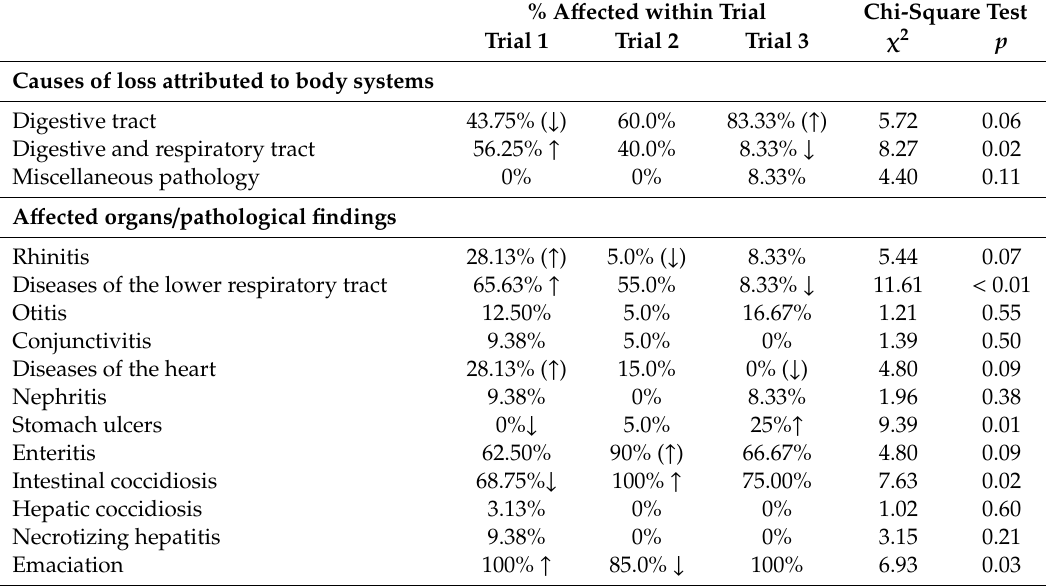
Arrows in brackets indicate trends, arrows without brackets indicate significant di ff erences between